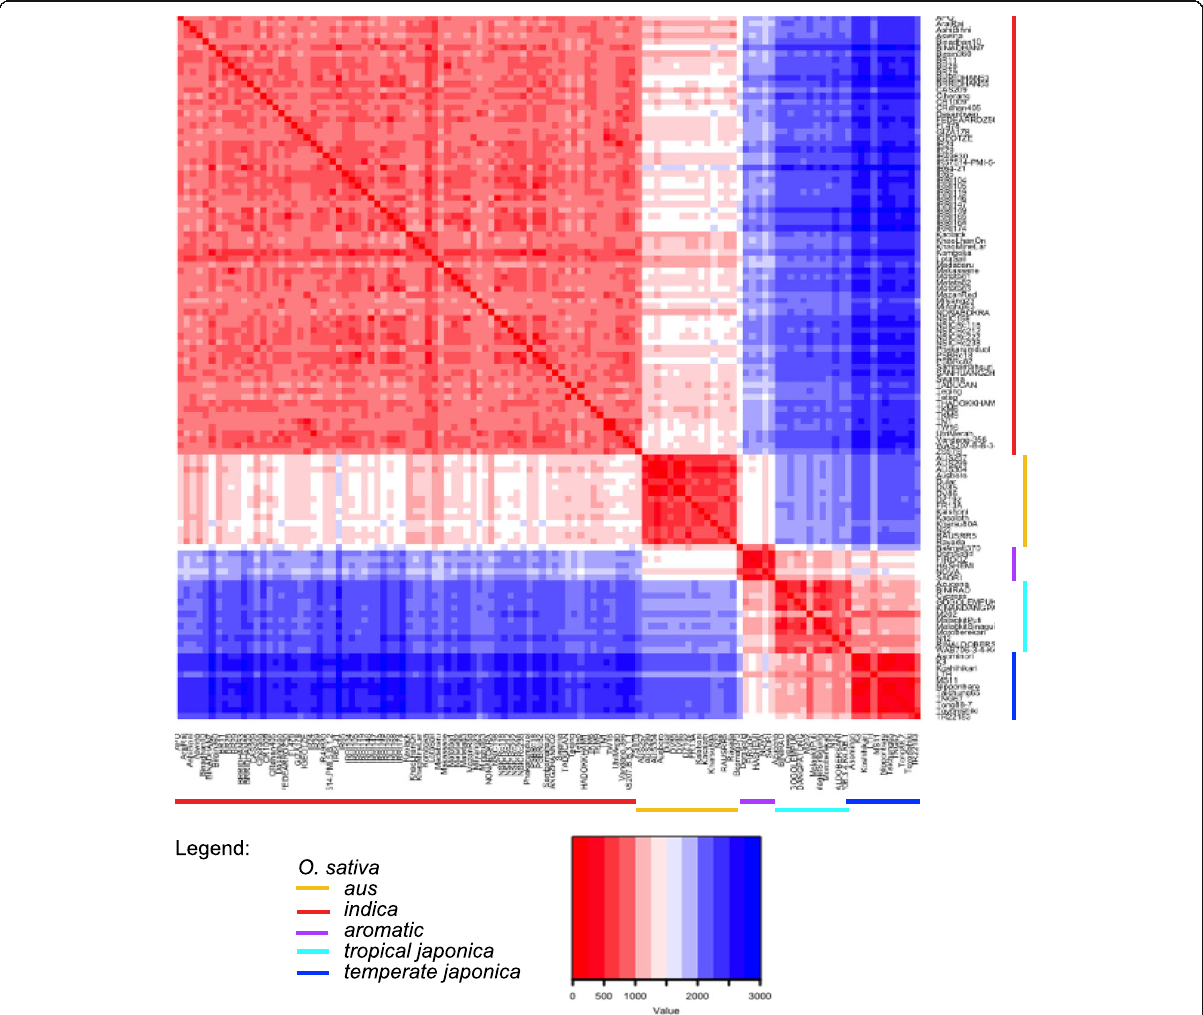
Fig. 3 Distribution of the number of polymorphic markers found in pairwise comparisons across the five rice subgroups: indica, aus, aromatic, temperate japonica and tropical japonica . The number of polymorphic SNPs is indicated in the heatmap